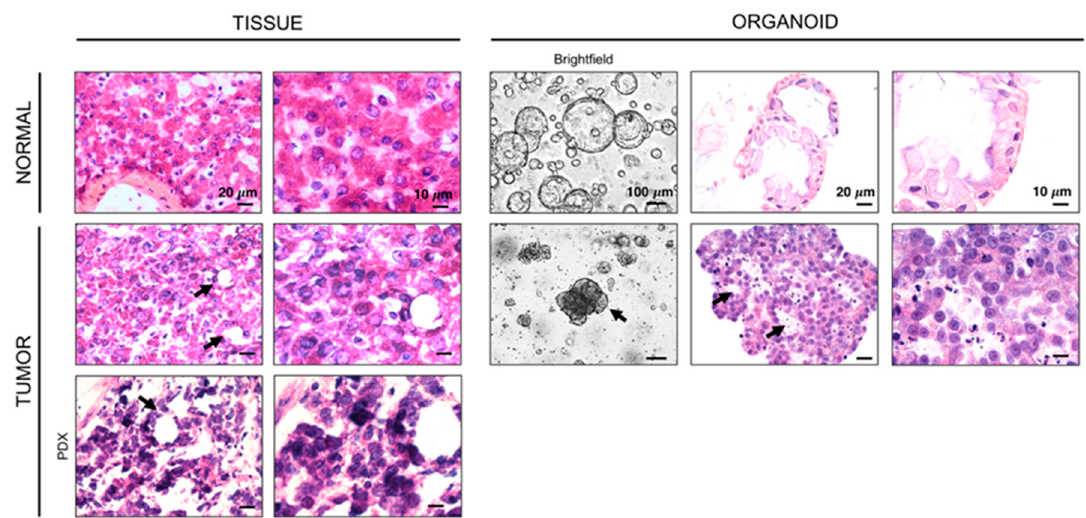
Figure 2. Representative hematoxylin and eosin staining of normal and tumor tissue and organoids from a patient with hepatoblastoma (HB8). Healthy liver and primary tumor tissue sections were obtained from frozen sections of tissue blocks that were used for whole exome sequencing (WES) and RNAseq. All images were obtained with a 60 × objective except brightfield images which were obtained with a 10 × objective. Normal tissue and organoid samples show relatively uniform cell size and shape, while hepatoblastoma tumor tissue and tumor organoids have a similar disorganized appearance and include immature tubular structures (dark arrows).